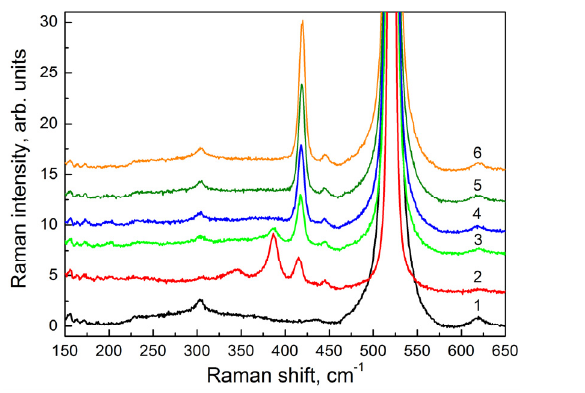
Figure 5. Raman spectra obtained for structures with different thicknesses of epitaxial films; left panel: 29 nm; right panel: 53 nm. Spectrum (1) corresponds to a Si(111) substrate, spectrum (2) corresponds to a film grown with simultaneous electron irradiation during deposition of CaF 2 . Other spectra correspond to regions of the films formed with postgrowth electron irradiation with different electron exposure times: (3)10 min; (4)4 min; (5)2 min; (6)1 min.